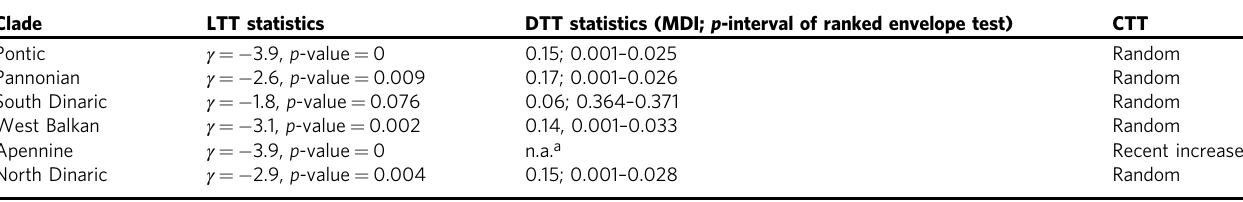
Table 4 Lineage through time (LTT), changes through time (CTT) and disparity through time (DTT) statistics for six major Niphargus